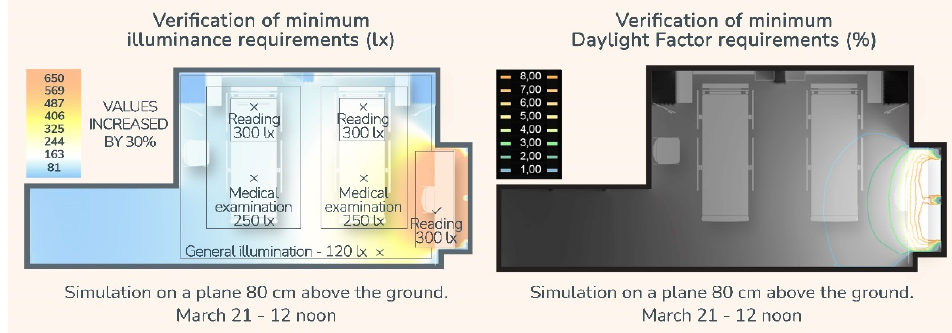
Figure 8. Room 1. Verification of minimum illuminance (lx) and daylight factor (%) requirements on ante operam.